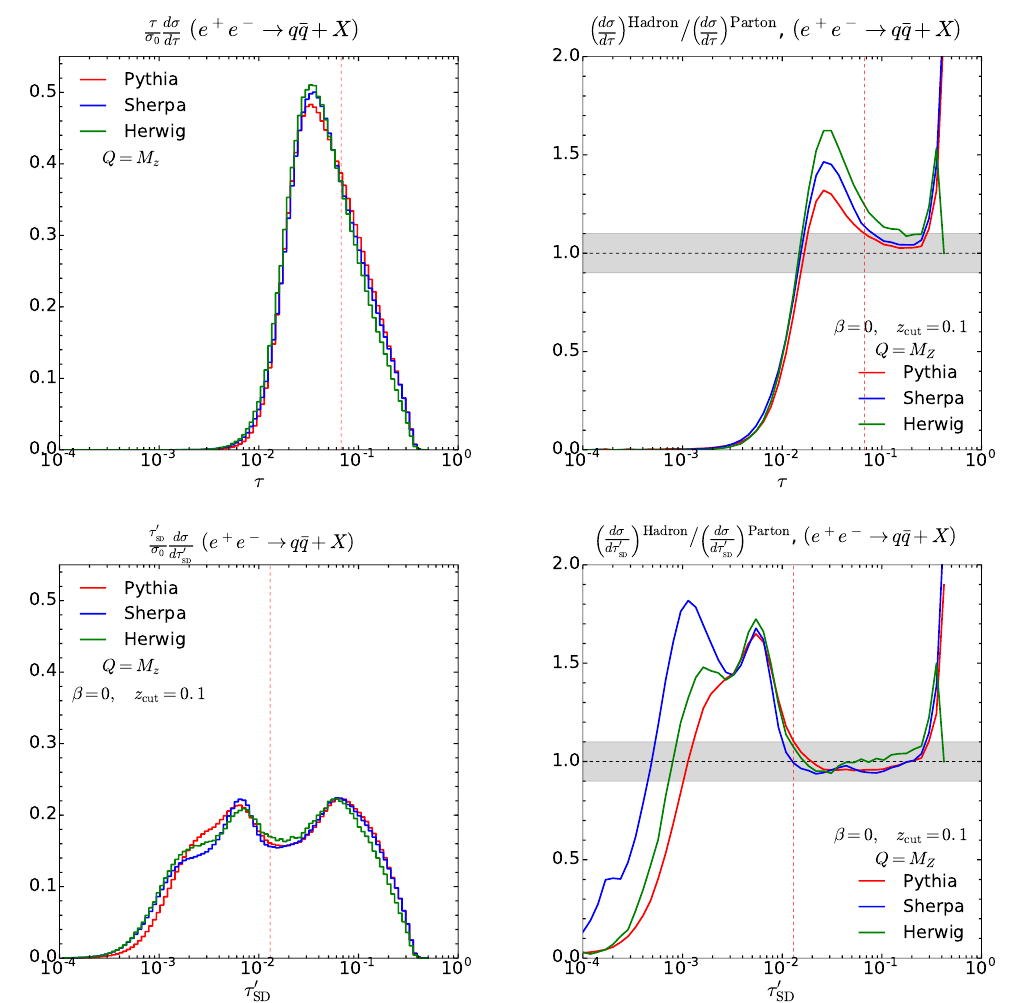
Figure 2 . Monte Carlo parton shower simulation of the thrust distribution (cid:28) = 1 T in e + e (cid:0) (cid:0) collisions, obtained using three general-purpose programs, as indicated in the legends. The plots at the top refer to the traditional (ungroomed) thrust distribution, while the bottom ones are for its soft-drop version (cid:28) 0 SD = 1 T 0 SD . The plots on the left show the normalised distribution, at the hadron (cid:0) level, while the plots on the right show the ratio of distributions obtained with hadronisation turned on and o(cid:11). We take these ratios as proxies to assess non-perturbative corrections. The vertical lines correspond to the values of thrust, or soft-drop thrust, for which hadronisation corrections, as estimated using the Pythia simulation, reach the 10%